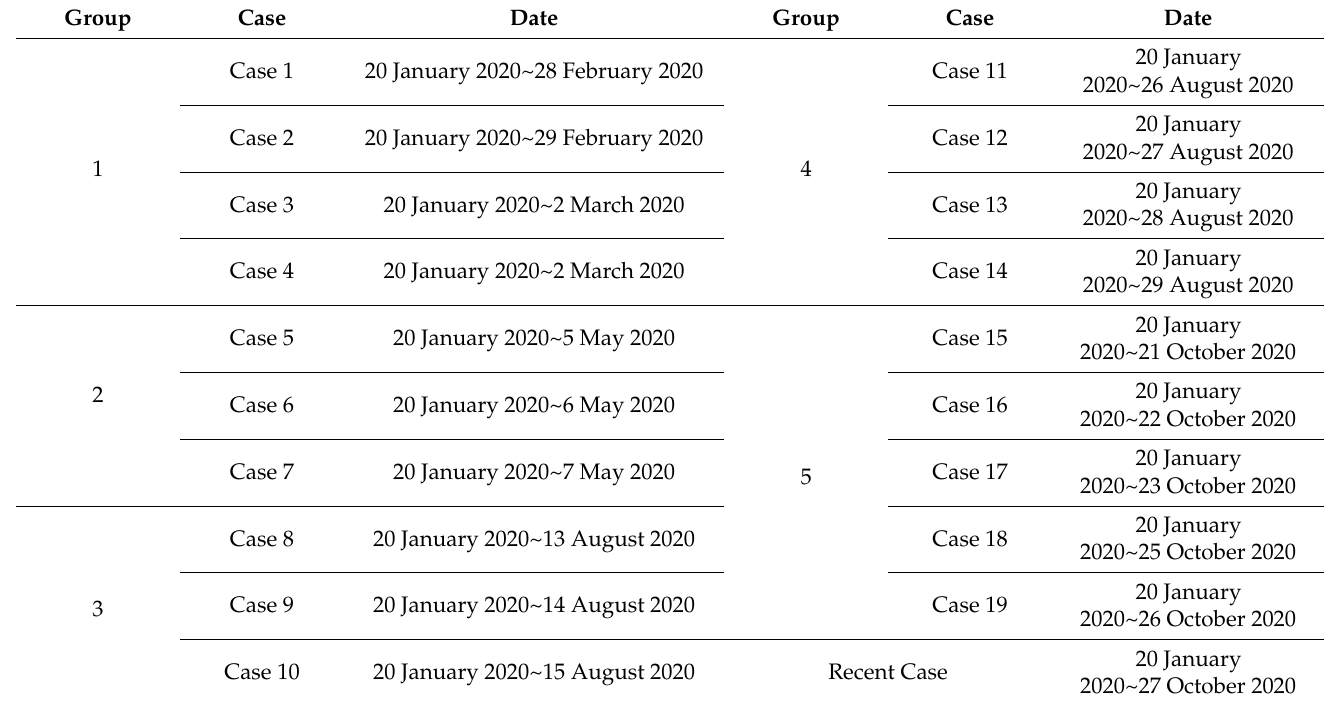
Table 2. Groups and cases by period for forecast